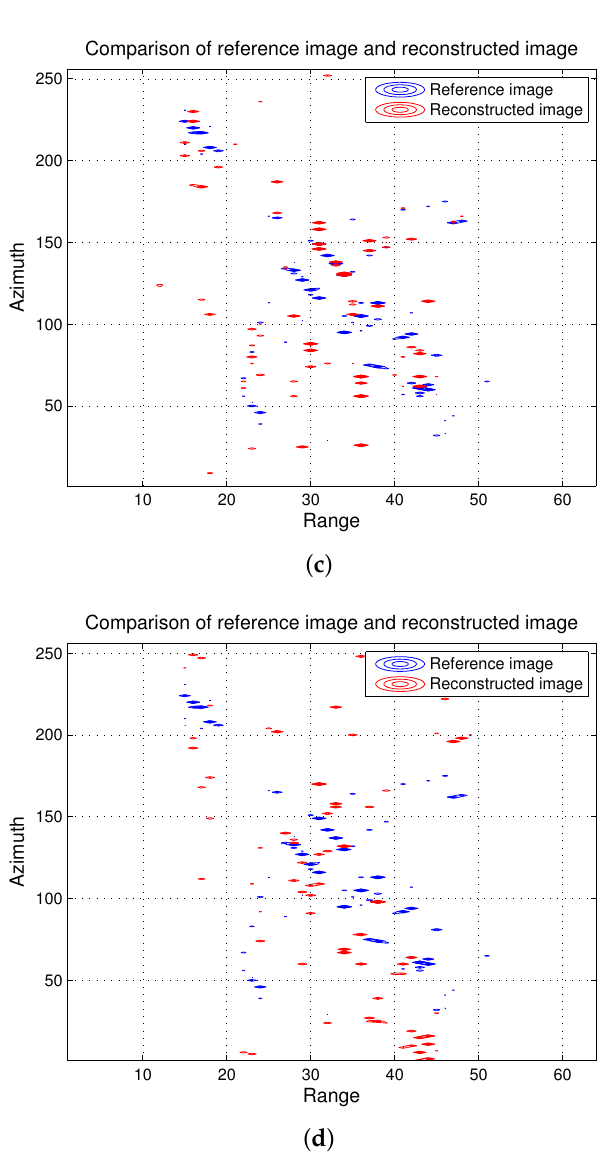
Figure 2. ( a ) Reference image; ( b ) overlap of reference and reconstructed images using DGAOMP with 50% downsampled data; ( c ) overlap of reference image and reconstructed image using an existing technique with 50% data; partial reconstruction can be seen as the technique was proposed for imaging with fully-sampled data; ( d ) overlap of reference image and reconstructed image using a dictionary without a rotational acceleration rate phase term with 50% data. The reconstruction fails to generate a discernible